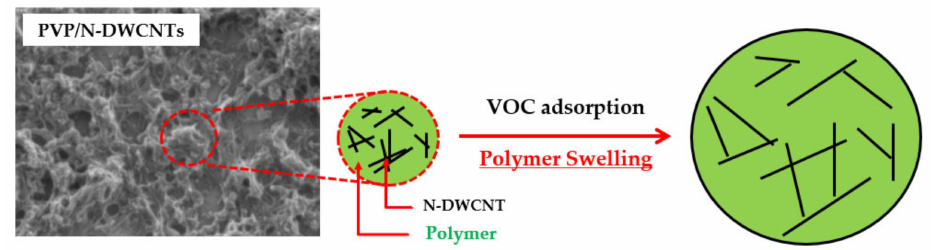
Figure 6. Schematic diagram of gas sensing mechanism of PVP/N-DWCNTs for VOC